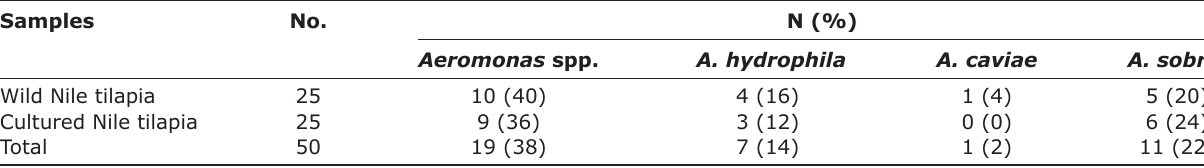
Gas from glucose +